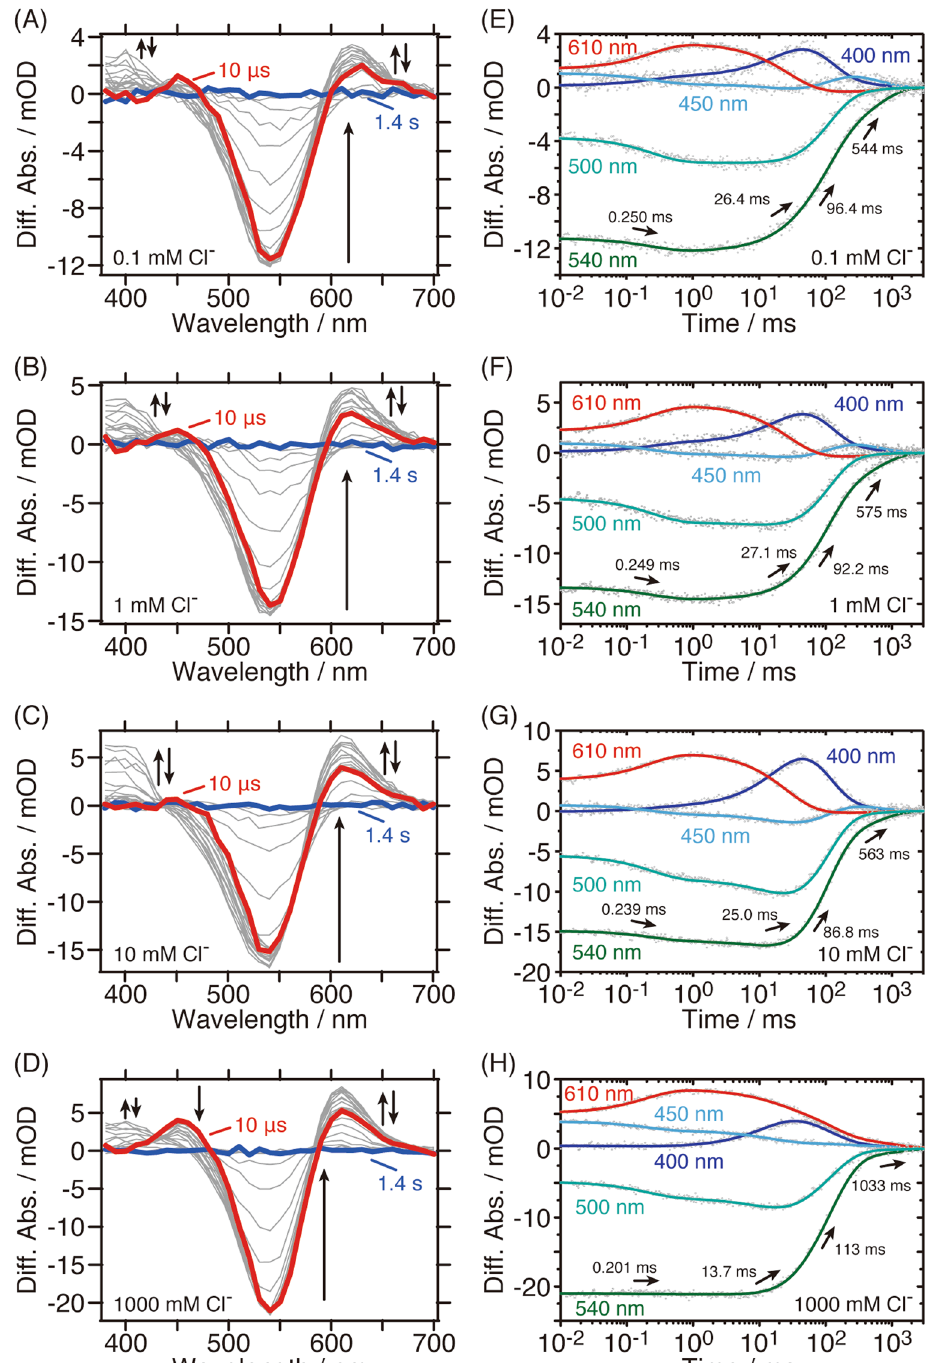
Figure 3. The Cl − dependence on the photocycle kinetics of Psu ACR1 in the presence of ( A , E ) 0.1, ( B , F ) 1, ( C , G ) 10 and ( D , H ) 1,000 mM Cl − . (Left panels) Flash-induced light minus dark difference absorption spectra. Red and blue lines represent the spectra at 10 μ s and 1.4 s, respectively. The directions of the evolution of the spectral changes are indicated by arrows. (Right panels) Time evolution of flash-induced absorption changes (shown as grey dots) of the initial state (540 nm), K and P 600 (610 nm), L (500 nm), P 450 (450 nm) and M (400 nm), respectively. Fitting curves are shown as solid lines with colors. Time constants are shown in the same